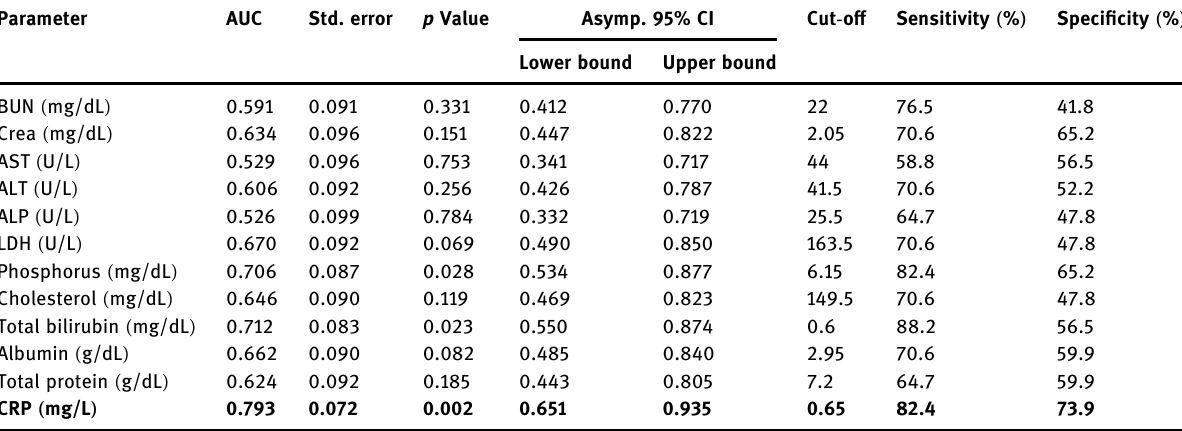
Table 10: Serum biochemistry fi ndings